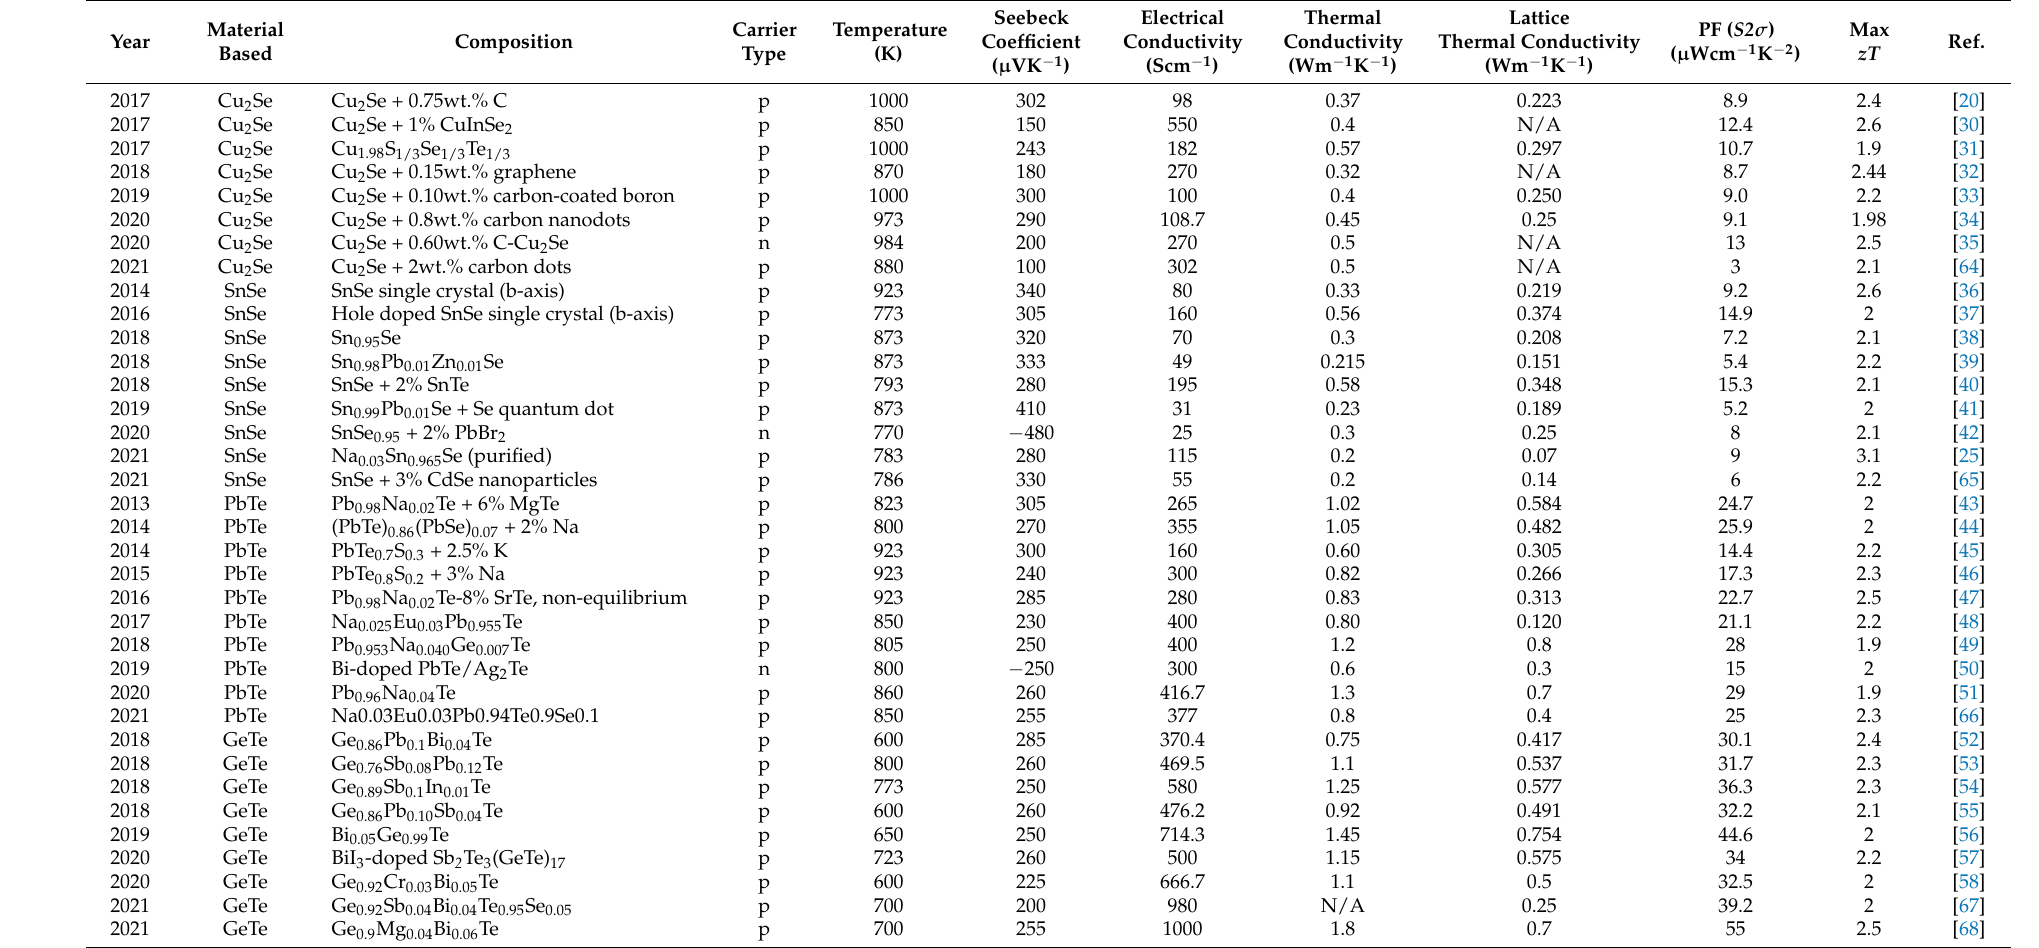
Table 1. State-of-art thermoelectric properties of mid-temperature thermoelectric